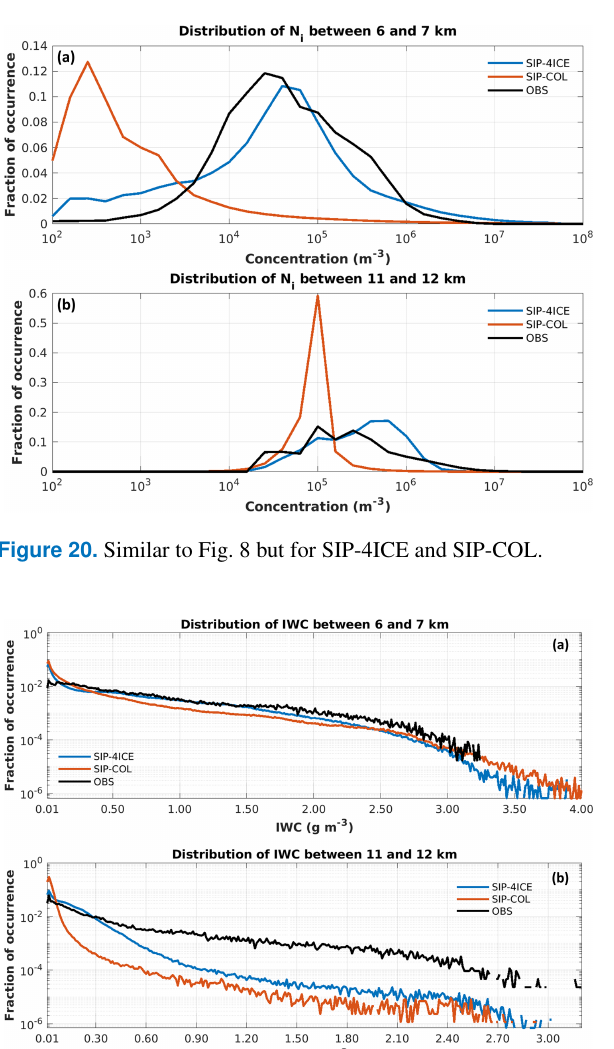
SIP-COL run produces ∼ 5 times higher F ( N i ) at N i